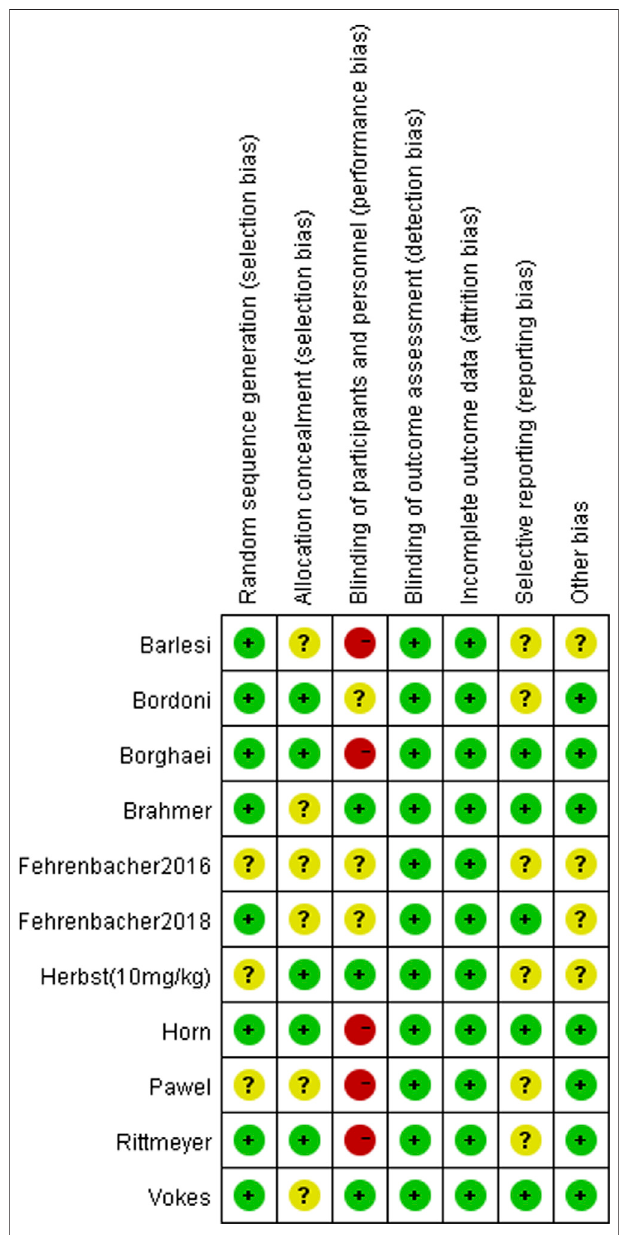
FIGURE 2 | Risk of bias